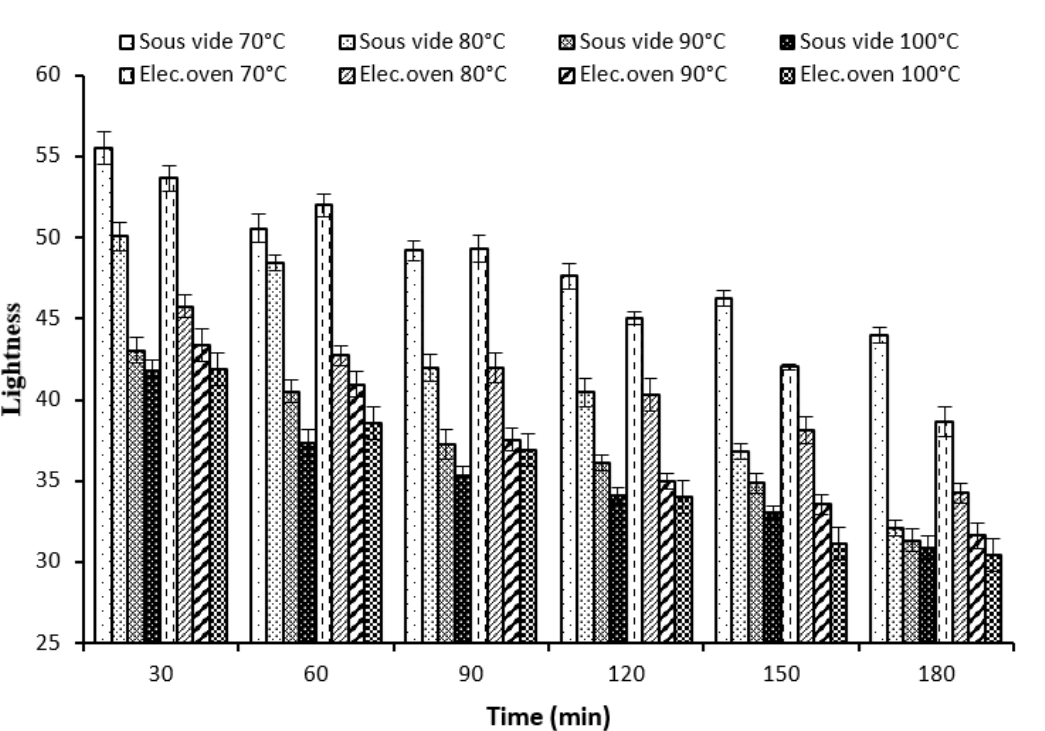
Figure 5. The effect of the cooking method (sous vide vs. electrical oven) on the camel meat color components (lightness L*) at different combinations of temperature and time.